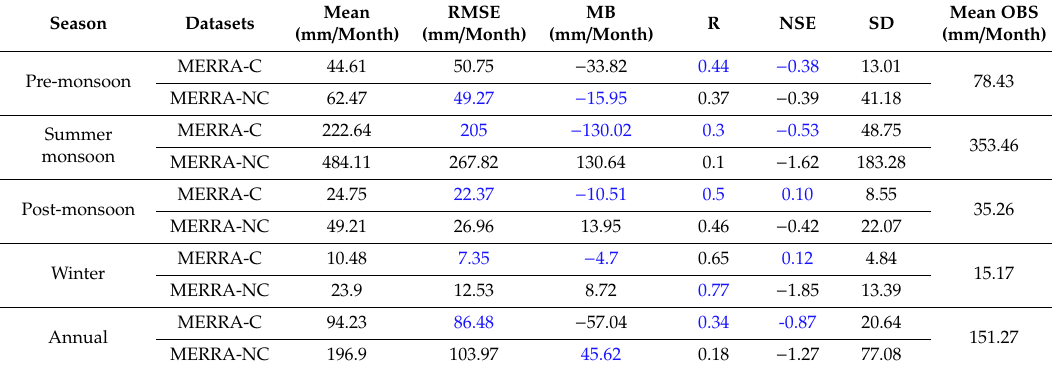
Table 2. Spatial performance of both MERRA-2 datasets for the di ff erent seasons during 2000–2018. SD represents the standard deviation of respective datasets. The blue font shows the best performance in the respective